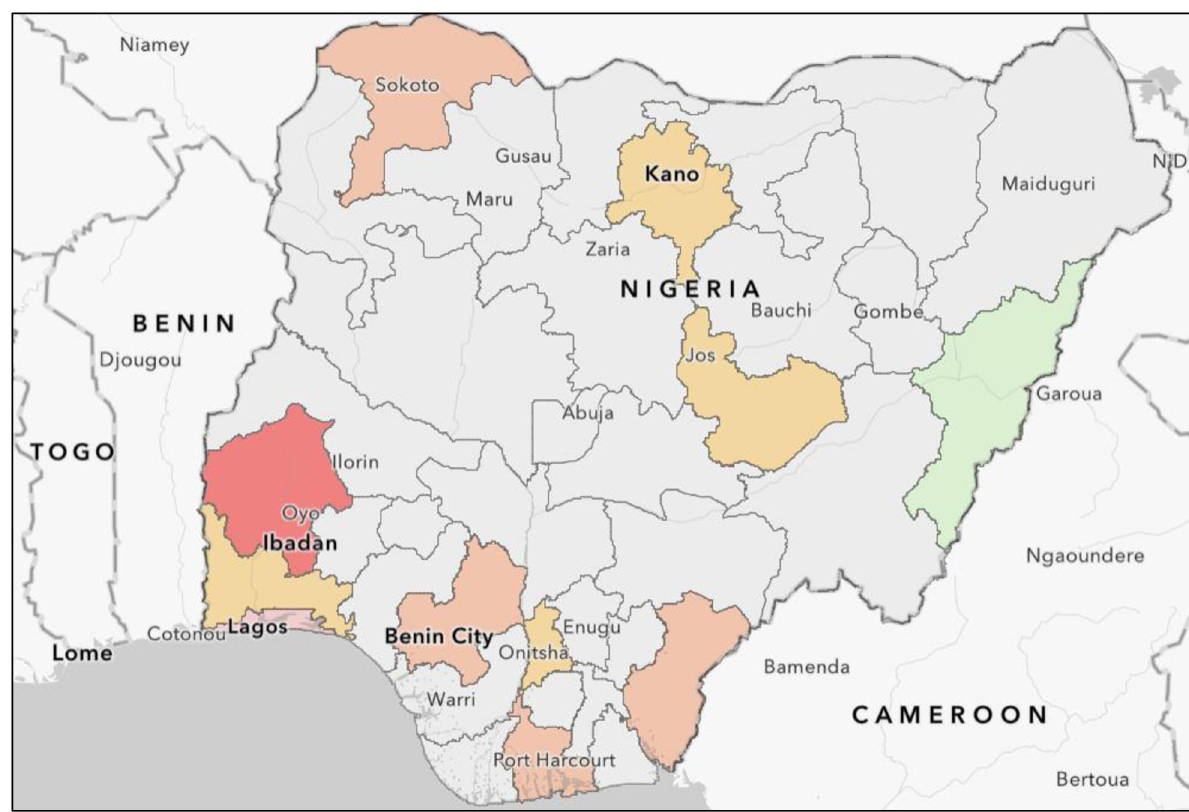
Fig 1. Map of Nigeria showing prevalence of cryptococcal antigenaemia at the various sites. Red–Greater than 10%; Pink– > 5 to 10%; Dark orange– > 3 to 5%; Light orange– > 0 to 3%; Green– 0%; Grey–No data (Map created using ArcGIS, basemap available at https://basemaps.arcgis.com/ arcgis/rest/services/World_Basemap_v2/VectorTileServer).